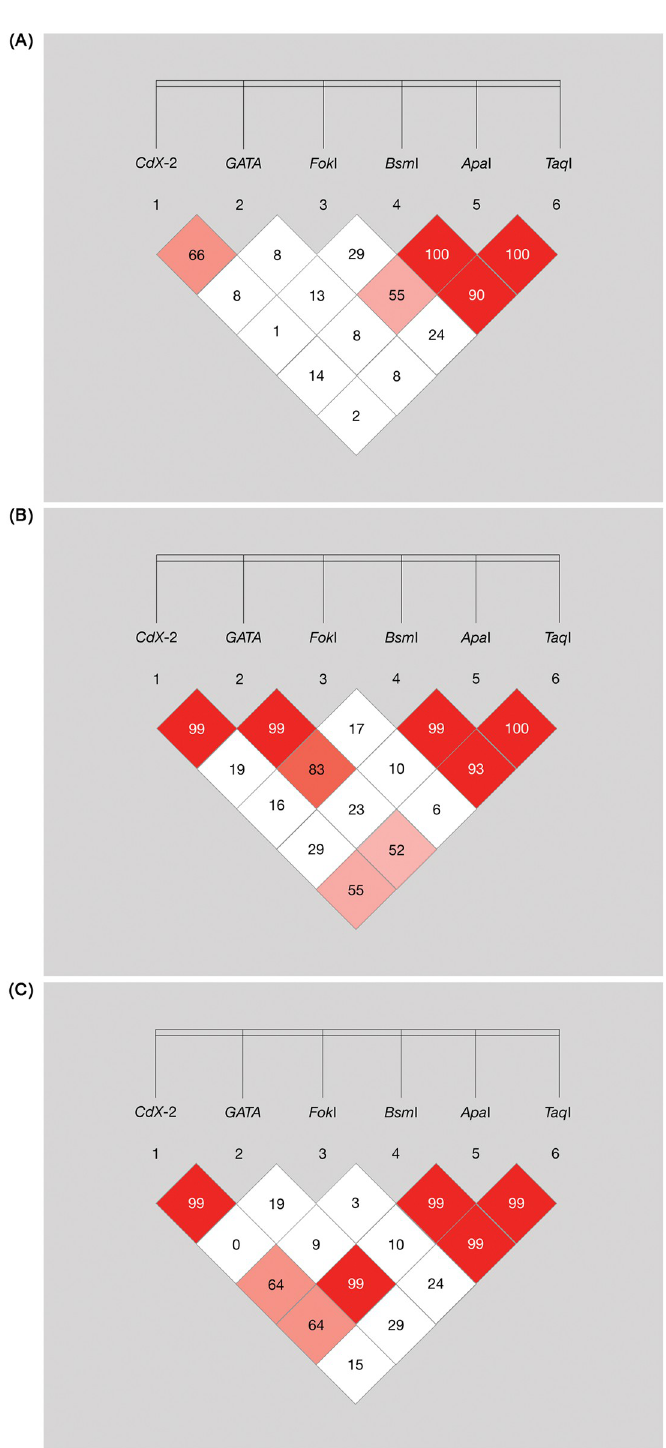
Fig 1. Genomic organization and linkage disequilibrium (LD) mapping of six SNPs of vitamin D receptor ( VDR ) gene. Patients with HBV inactive carrier (IC), chronic hepatitis (CH) phases and the general population.